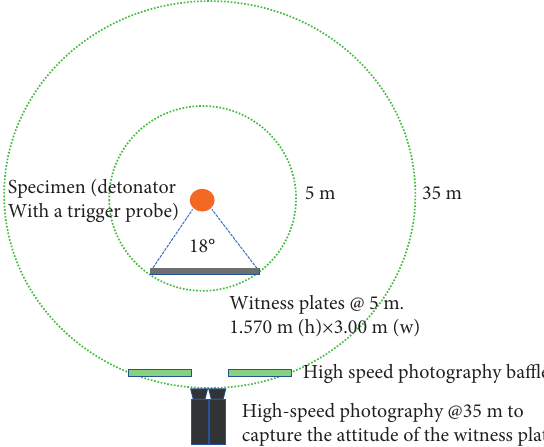
Figure 2: Schematic view of experimental setup (top